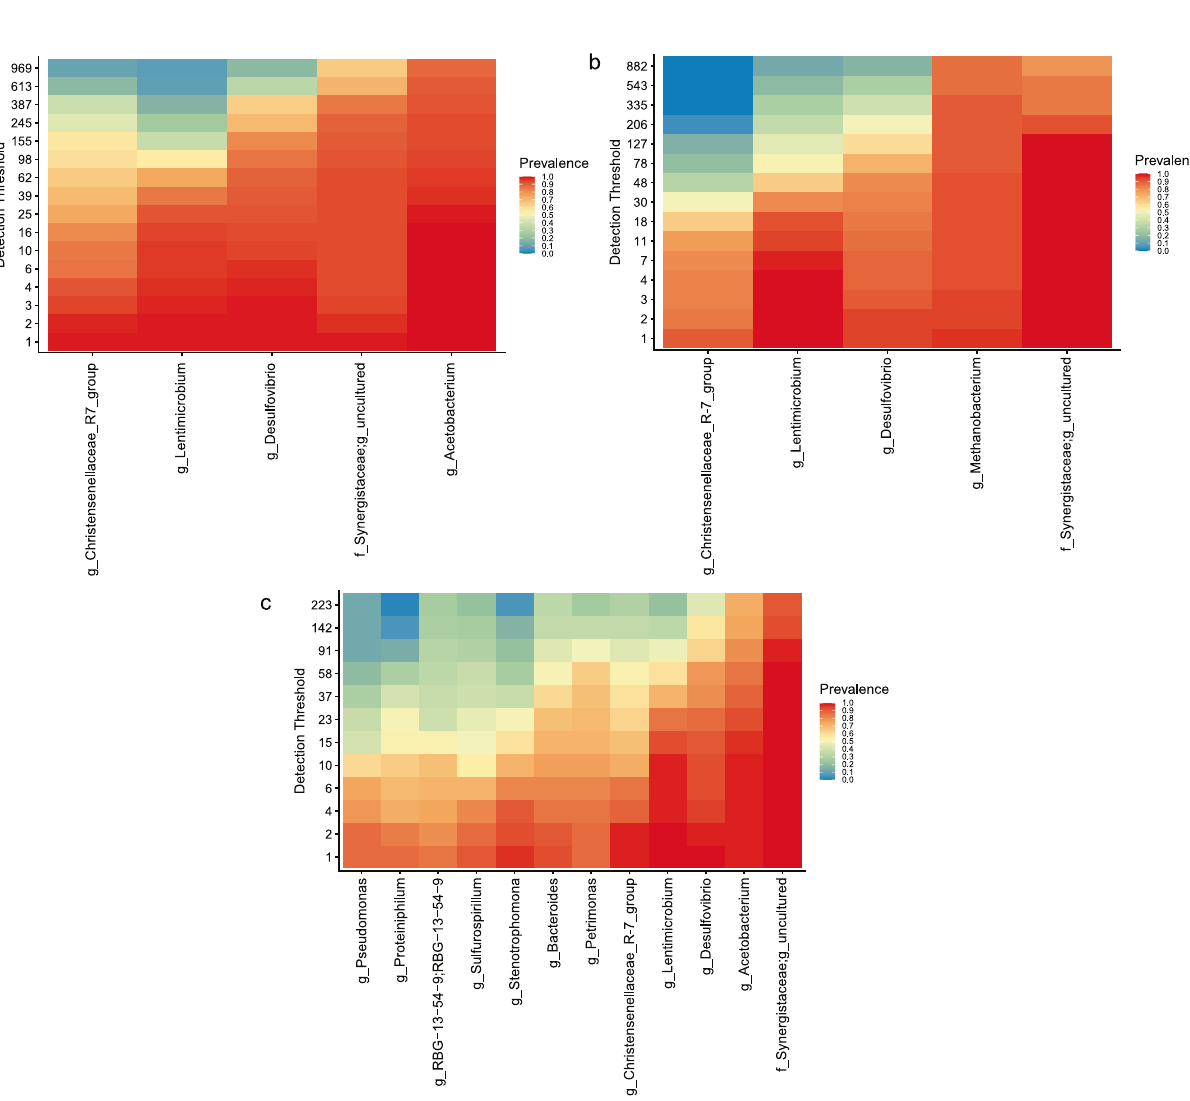
Fig. 2 Core microbiomes of acetogenic and methanogenic MES cells. a Highly prevalent taxa in the core microbiomes of ( a ) acetogenic cathodic, b methanogenic cathodic and c acetogenic planktonic communities. Detection thresholds (number of reads) are shown on the